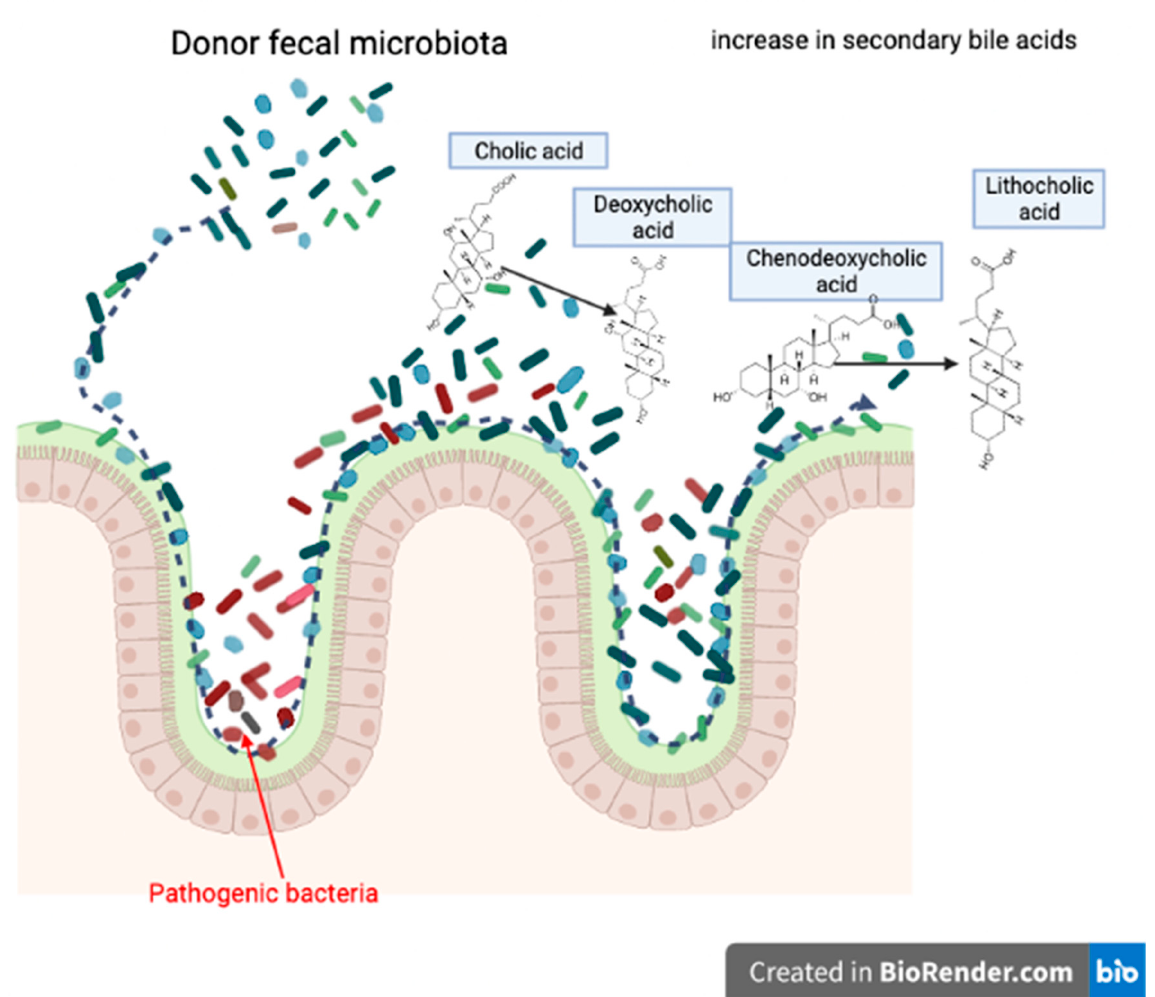
Figure 5. Potential mechanism of FMT; increased production of secondary bile acids. (Created with BioRender.com, accessed date 18 June